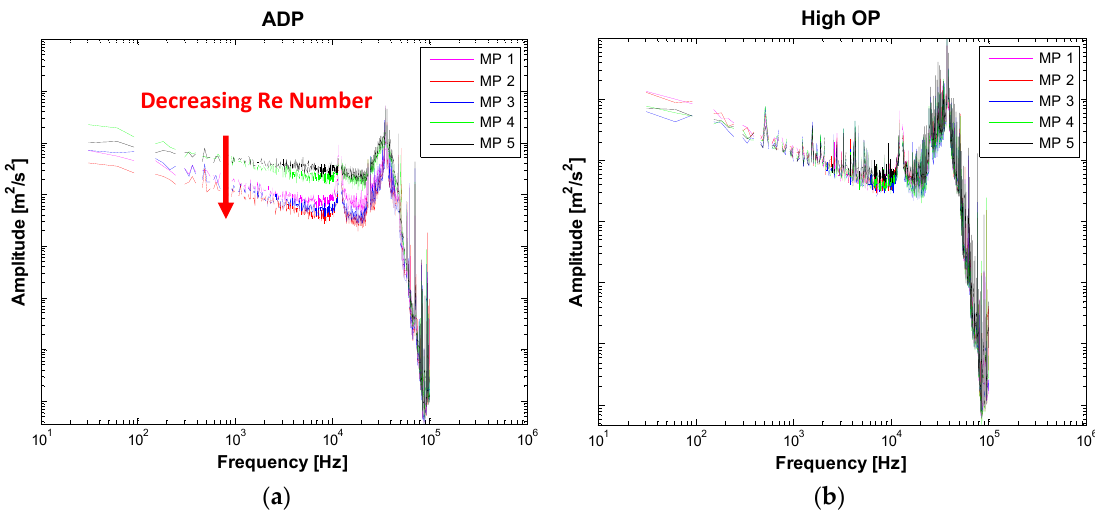
Figure 6. Energy spectra of measurement data comparing different radial measurement positions for two operating points ( a ) ADP and ( b ) high OP.